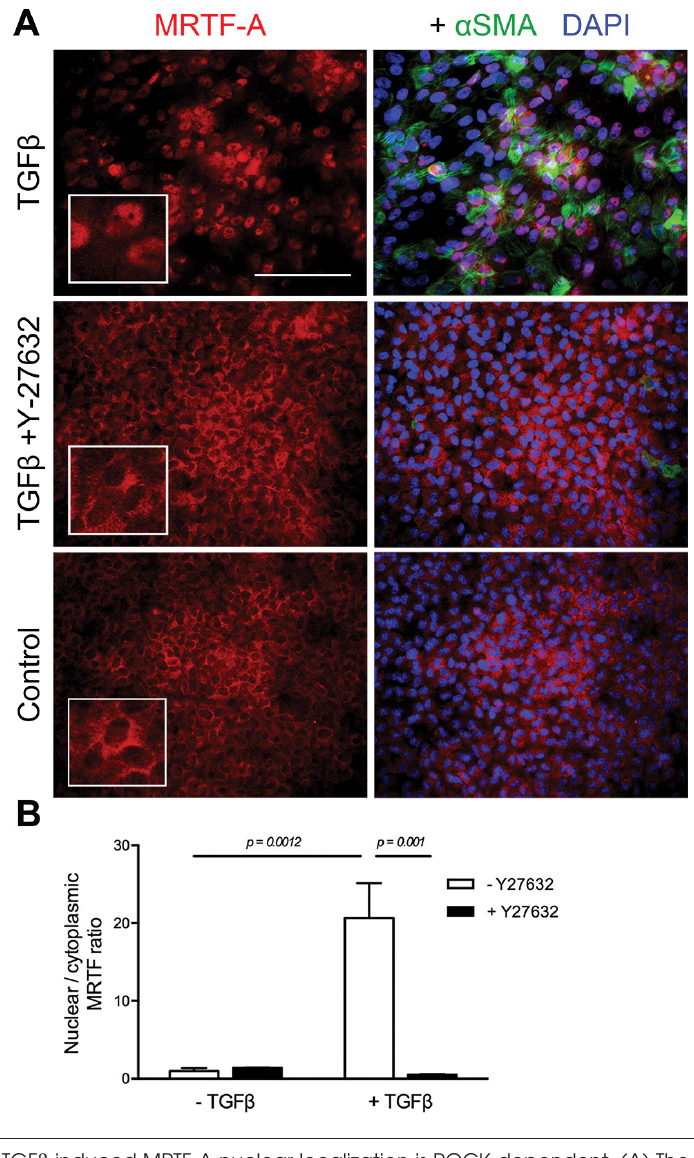
Figure 4. TGF β -induced MRTF-A nuclear localization is ROCK-dependent. (A) The presence of Y-27632 (20 μ M) prevented nuclear localization of MRTF-A in response to TGF β (4 ng/mL) treatment for 48 h. Fixed explants were costained for MRTF-A and α SMA and mounted in medium with DAPI to colocalize nuclei. (B) Quantification of the ratio of nuclear-to-cytoplasmic MRTF-A signal by measuring intensity of fluorescence in images as described in Materials and Methods. Data expressed as means ± SEM from three separate experiments. Scale bar and insets = 100 μ m